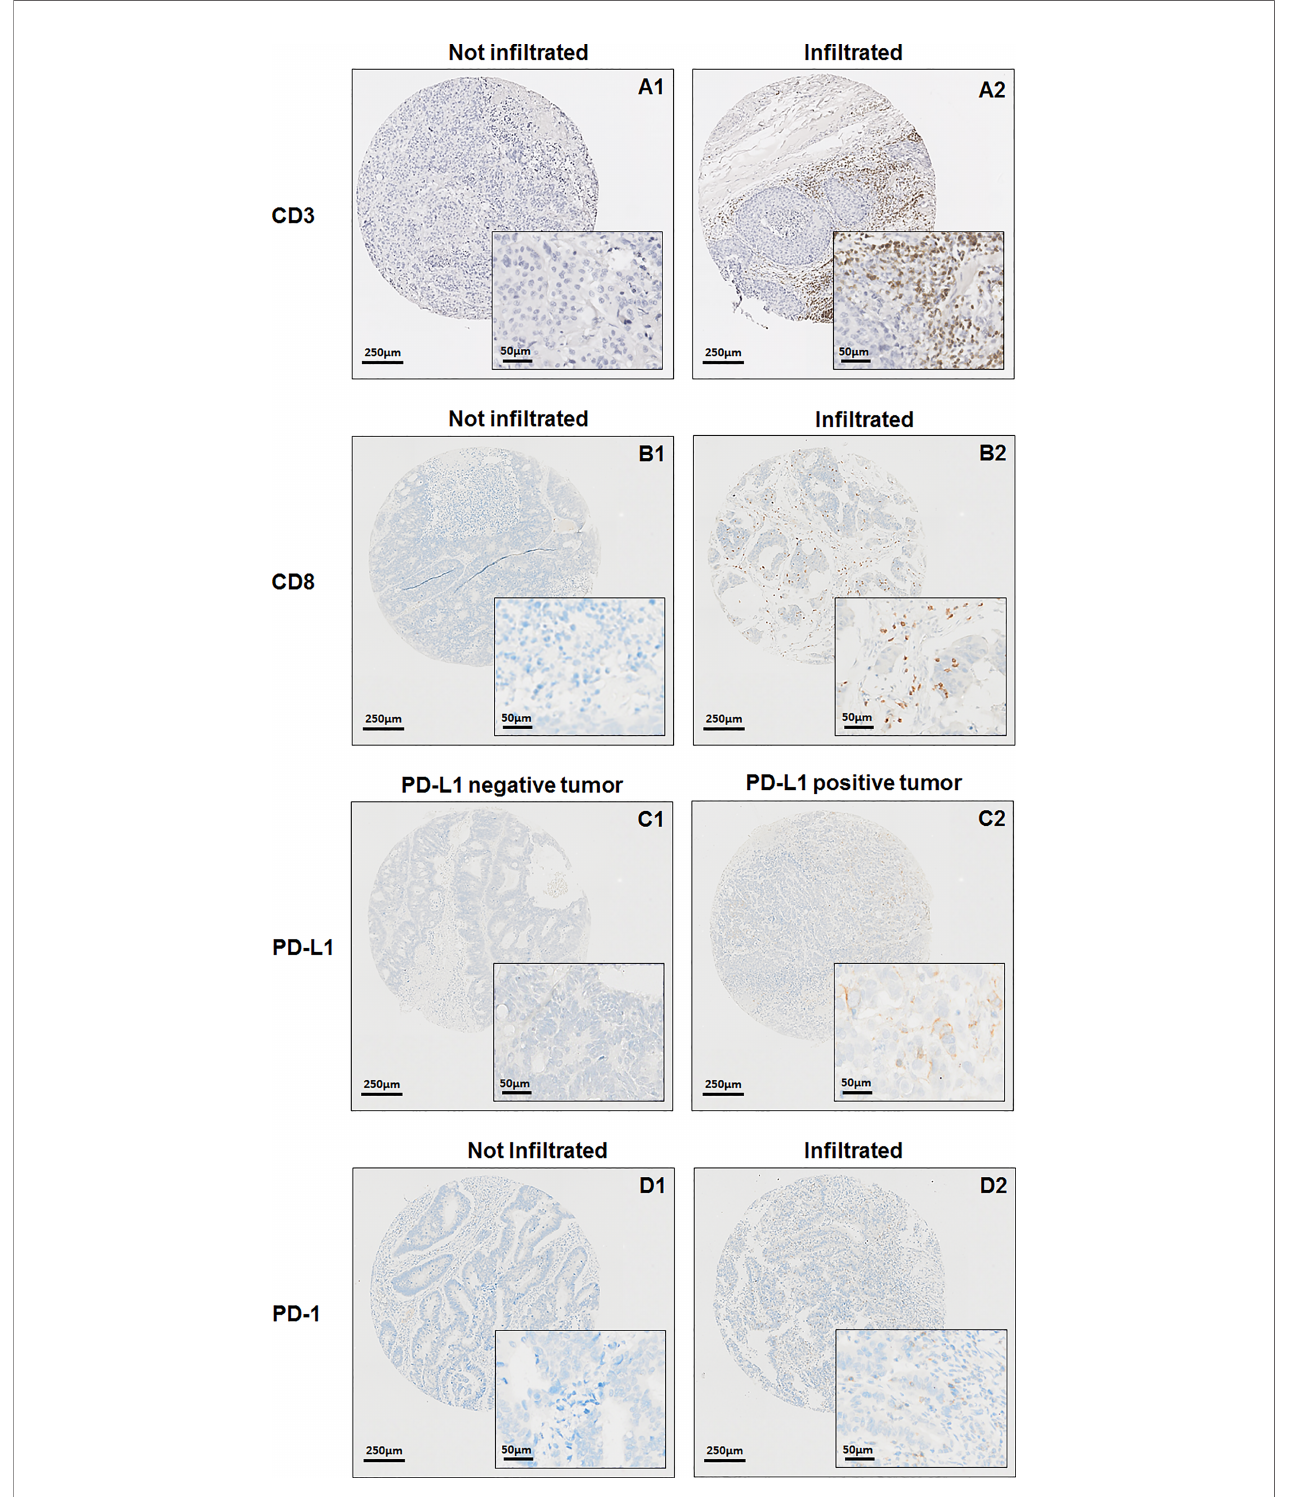
FIGURE 1 | Median overall survival after brain metastases diagnosis. Kaplan-Meier method was used to determine